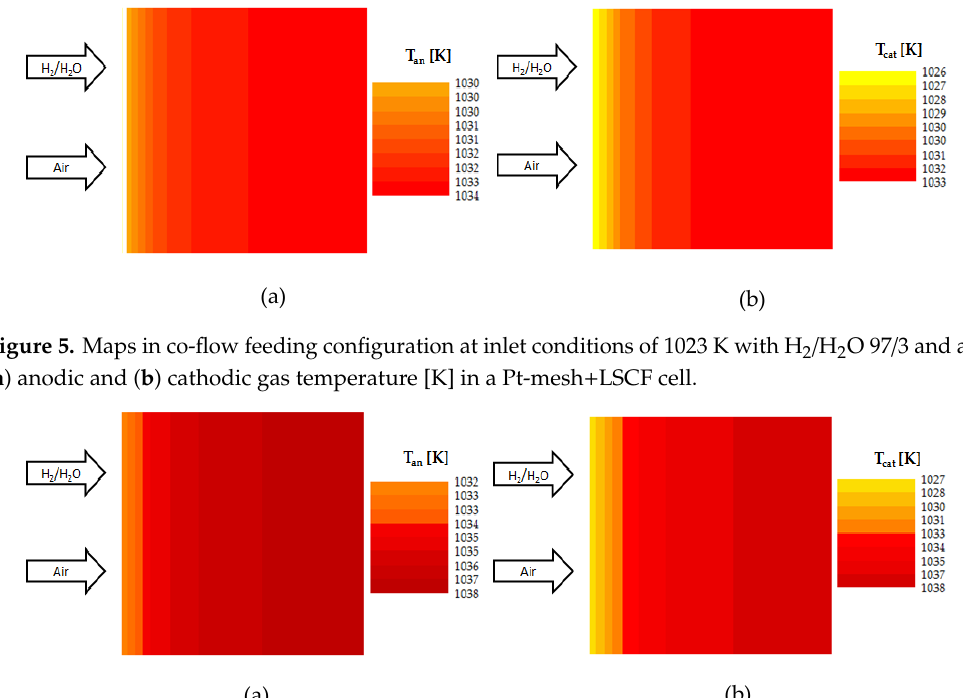
Figure 6. Maps in co-flow feeding configuration at inlet conditions of 1023 K with H 2 /H 2 O 97/3 and air: ( a ) anodic and ( b ) cathodic gas temperature [K] in Pt-mesh cell.